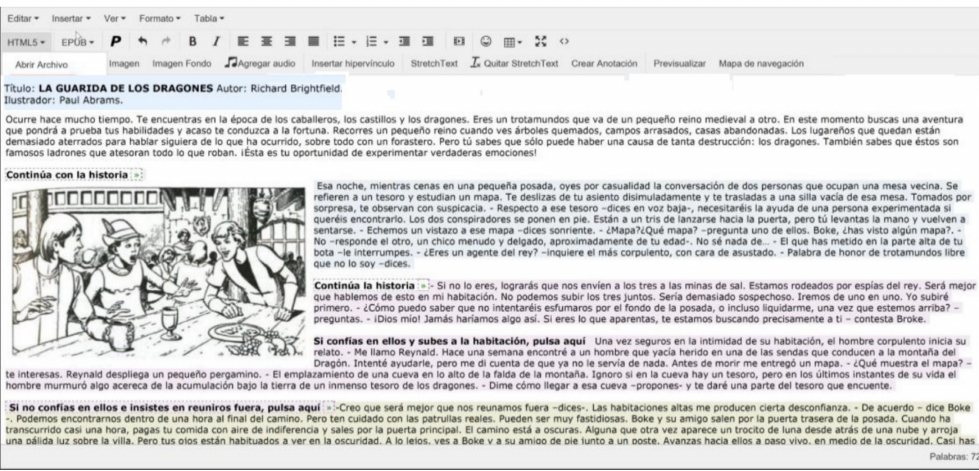
Figure 4. Example of an